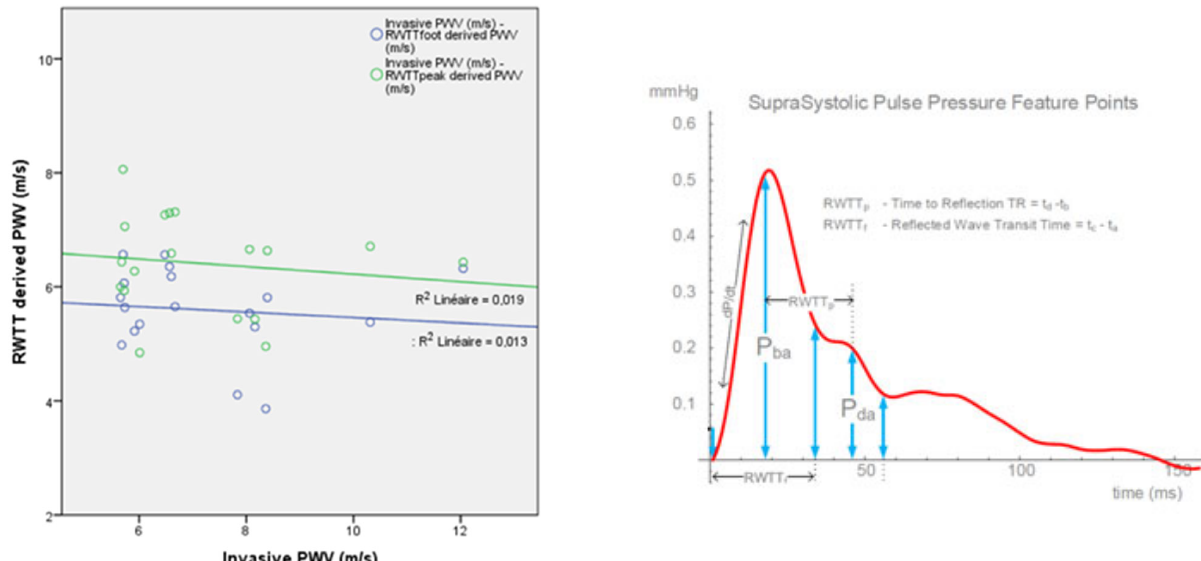
Figure 10. On the left , correlation plot between the invasive aorto-brachial pulse wave velocity (PWV) and the reflected wave transit time (RWTT) derived PWV, showing a lack of correlation between both parameters. On the right , representation of a suprasystolic brachial pulse pressure wave and definition of RWTT peak (RWTTp) and RWTT foot